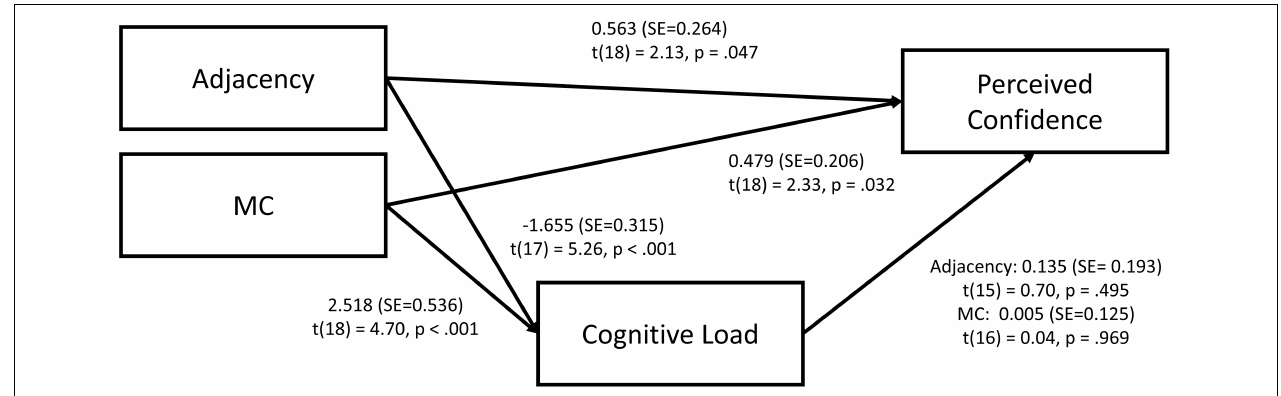
FIGURE 6 | Mediation model for adjacency and MC on perceived confidence via cognitive load.